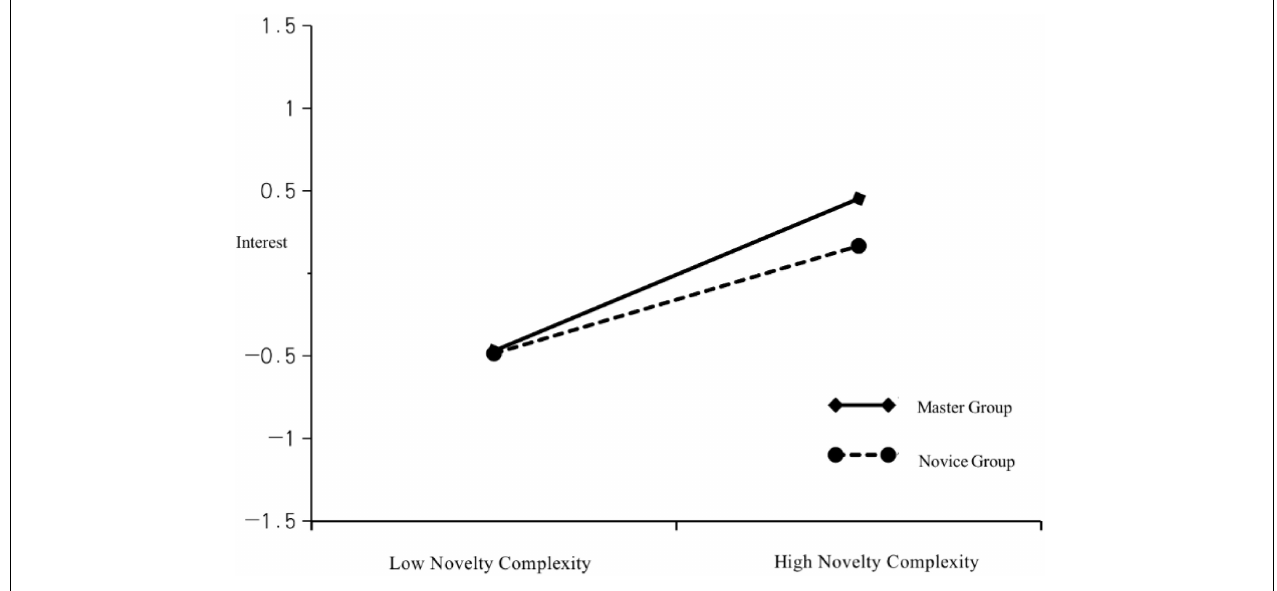
FIGURE 3 | Adjustment chart of group type for interest and novelty–complexity.